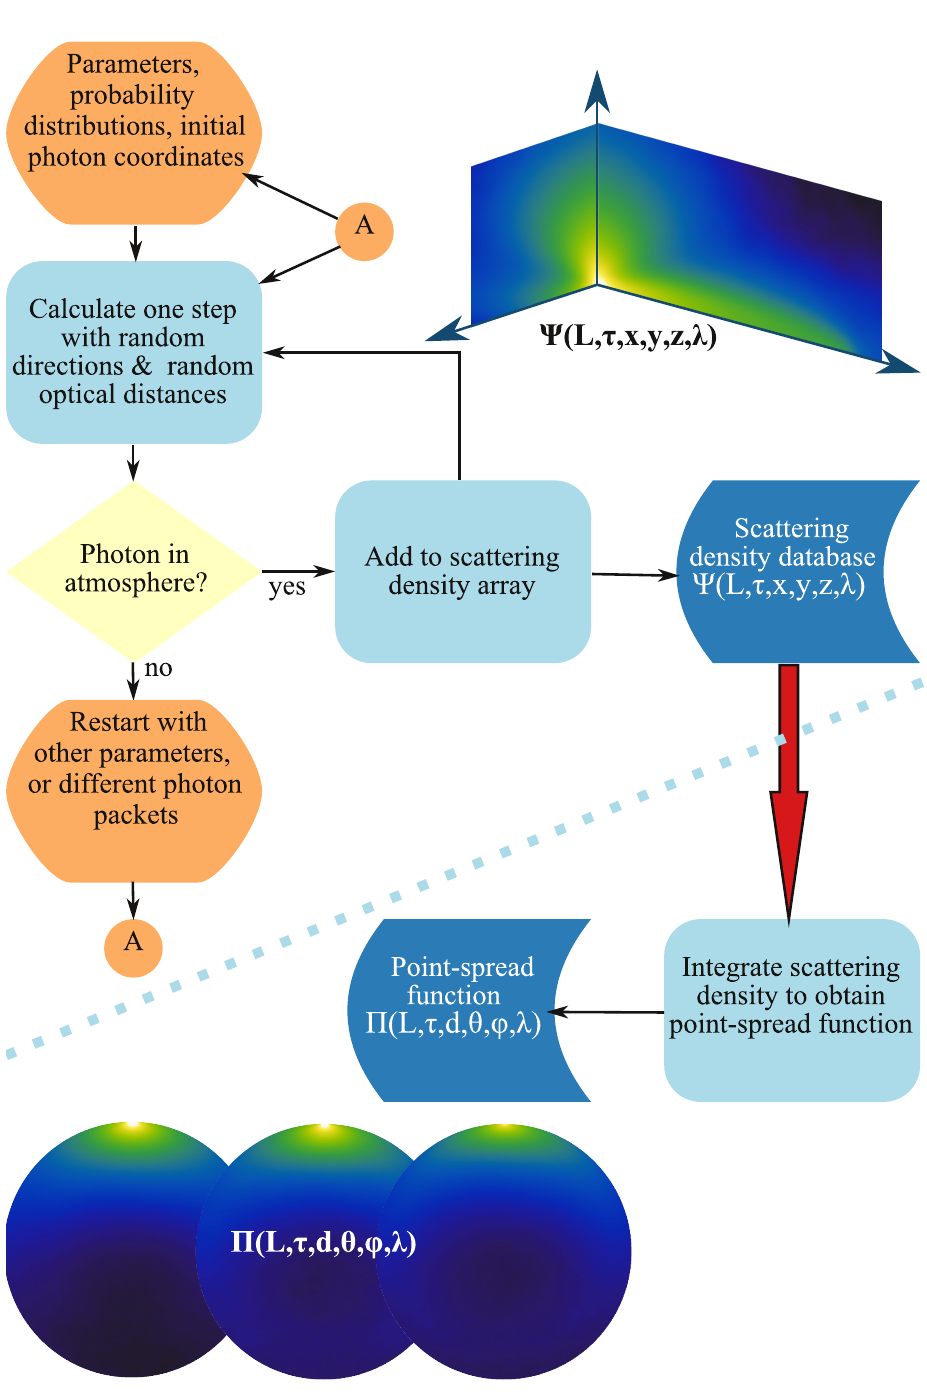
Figure 5. Flowchart of the Monte Carlo